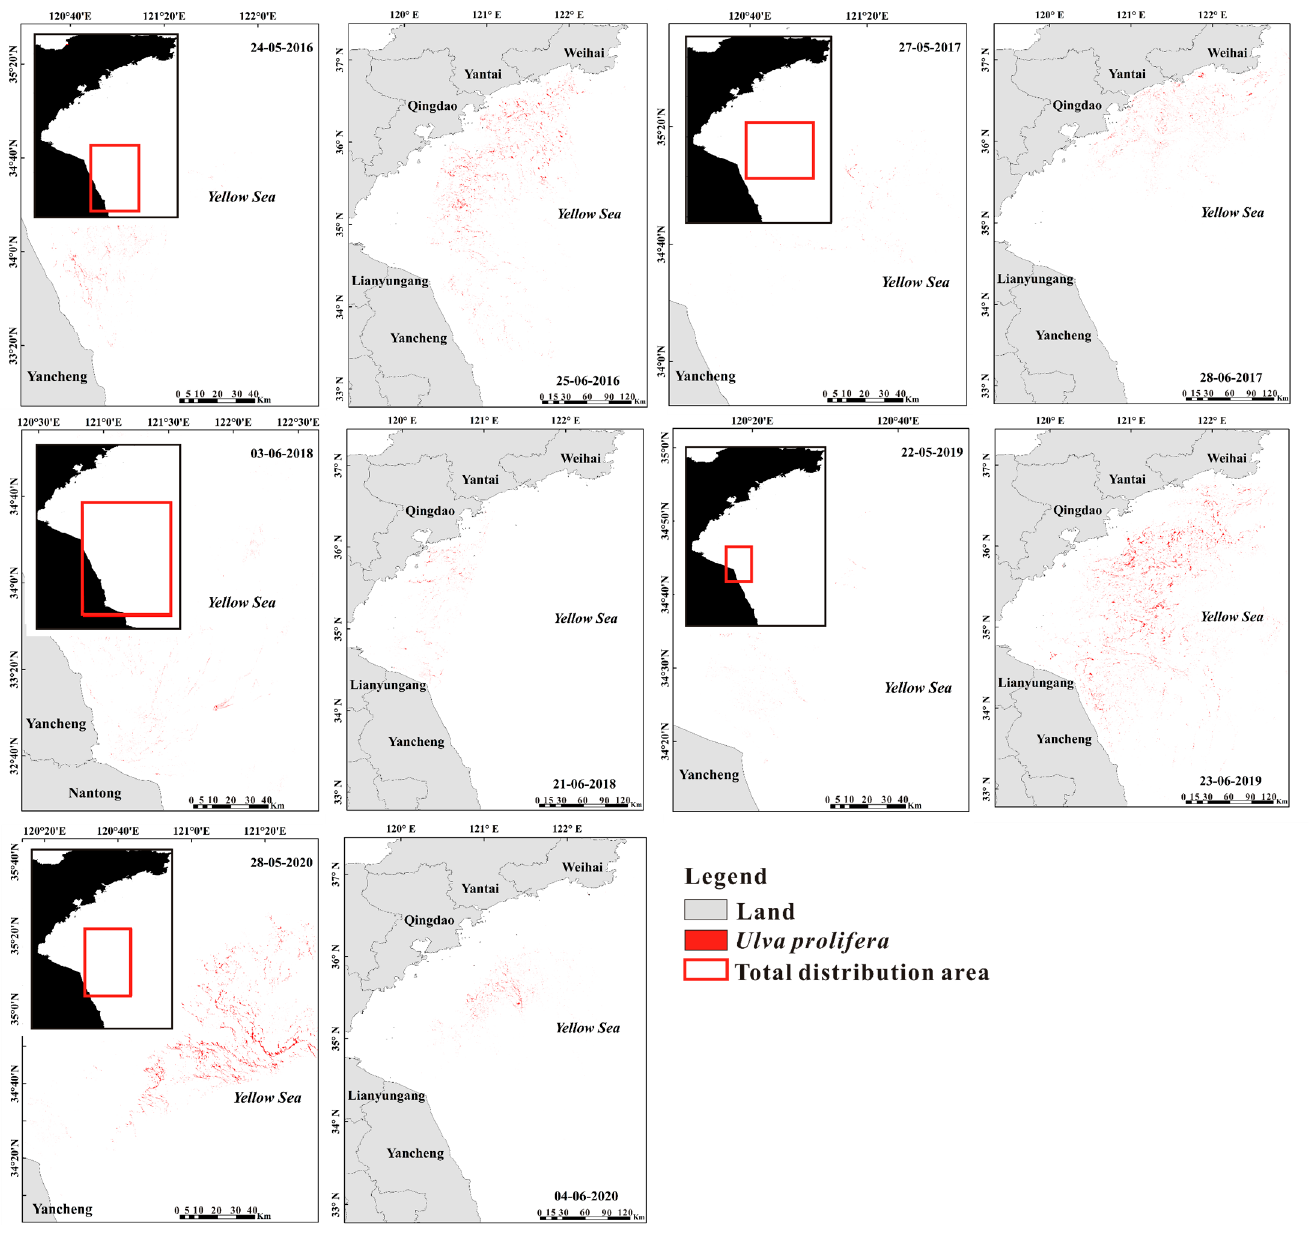
Figure 11. Temporal and spatial distribution of U. prolifera in the study area from 2016 to 2020. Only two representative images with the earliest discovery date and the largest daily area of U. prolifera were selected for each year.